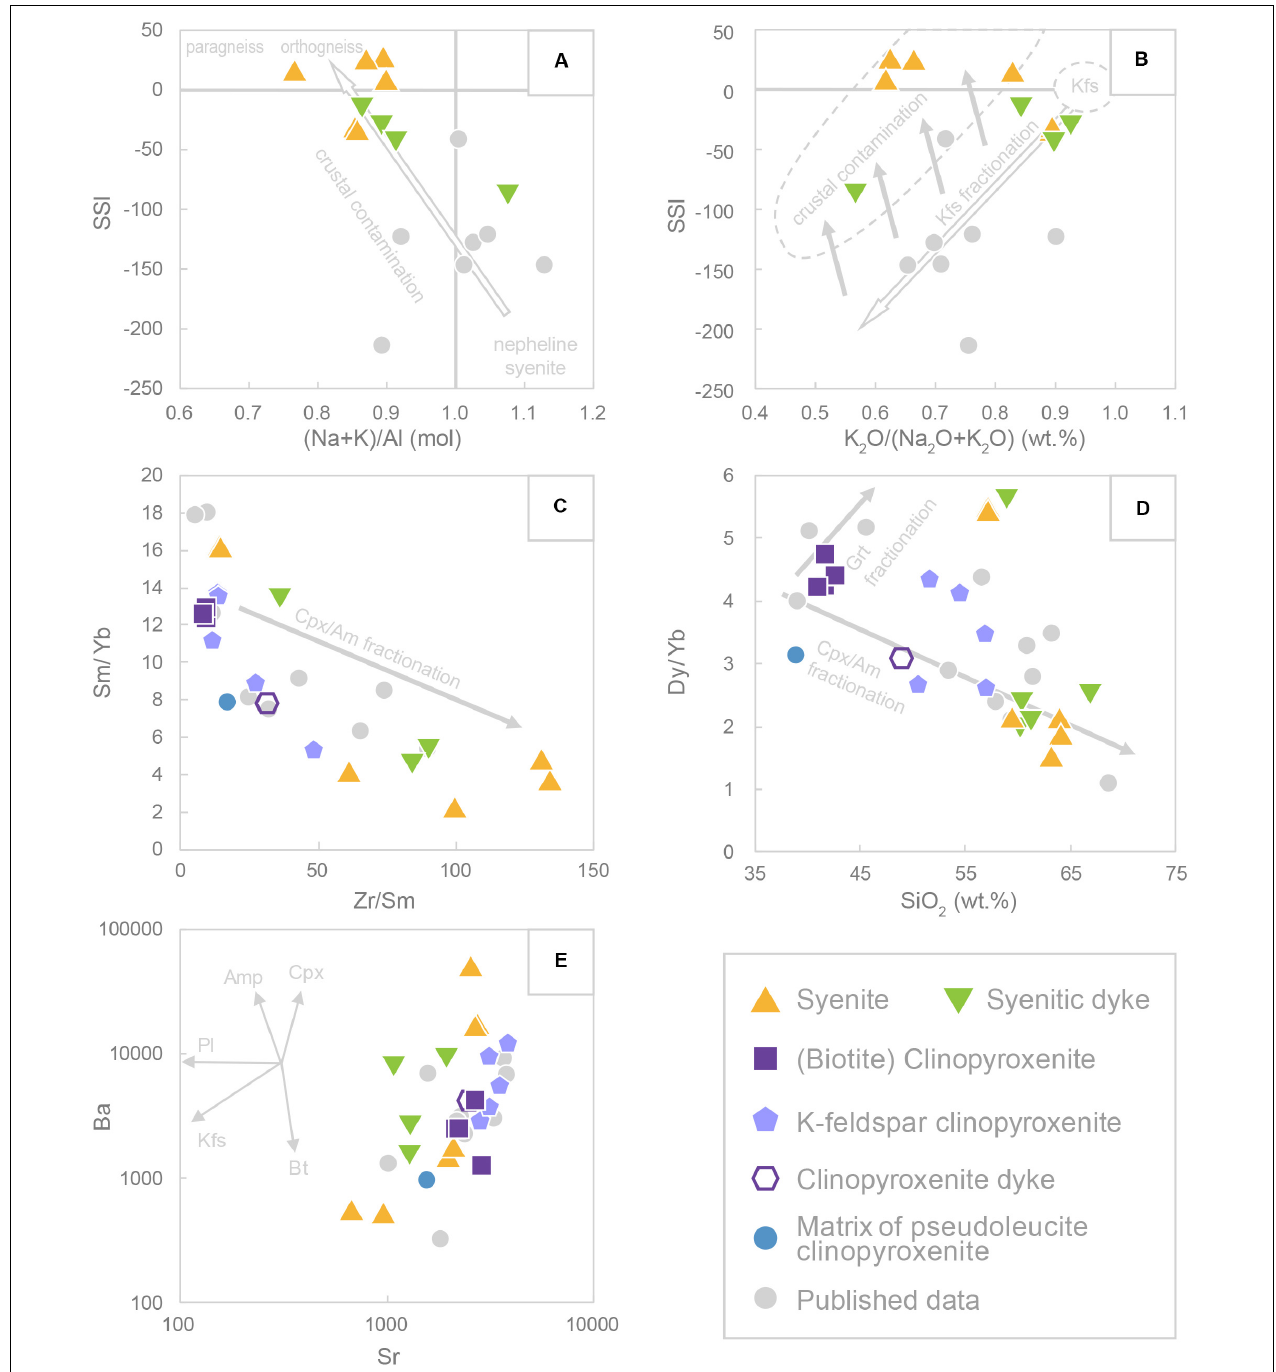
FIGURE 14 | (A,B) Silica saturation index (SSI) vs. (Na + K)/Al (mol.) and K 2 O/(Na 2 O + K 2 O) (wt.%) diagram to discriminate the crustal contamination process (Motoki et al., 2010); (C) Sm/Yb vs. Zr/Sm diagram depicting clinopyroxene/amphibole fractionation trend after Xin et al. (2020); (D) Dy/Yb vs. SiO 2 diagram illustrating the fractionation of clinopyroxene/amphibole and garnet after Davidson et al. (2007); (E) Ba vs. Sr diagram demonstrating the fractionation of various crystals after Xin et al. (2020). Published data are from Chen et al. (2013).